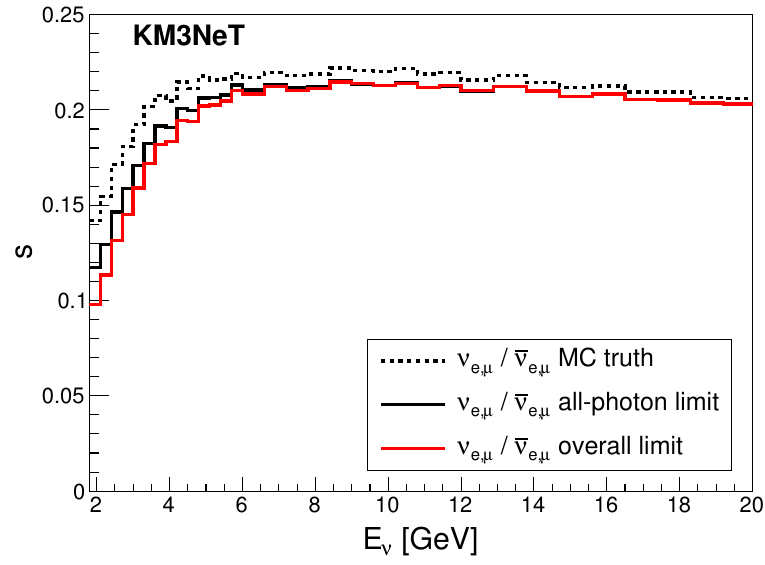
Figure 18 . Separation power s (eq. (5.2)) between (cid:23) and (cid:23) , using the Monte Carlo truth distribu- tions P ( y true ), and reconstructed distributions P ( y reco ) in the all-photon and overall